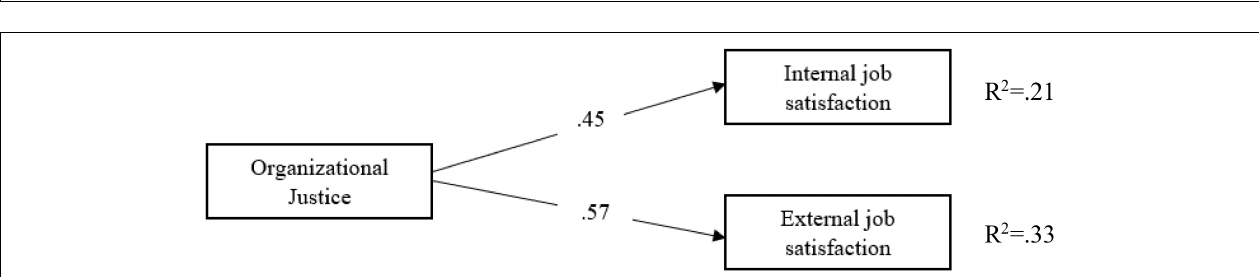
FIGURE 3 | The relationship between agile leadership and organizational justice.